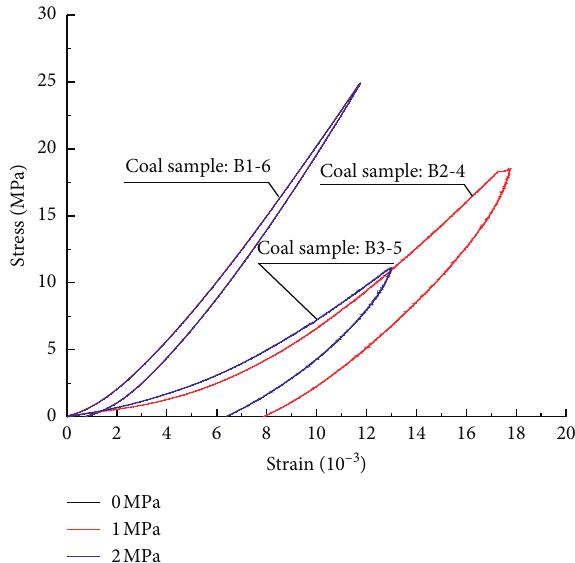
Figure 9: Loading and unloading curves of coal